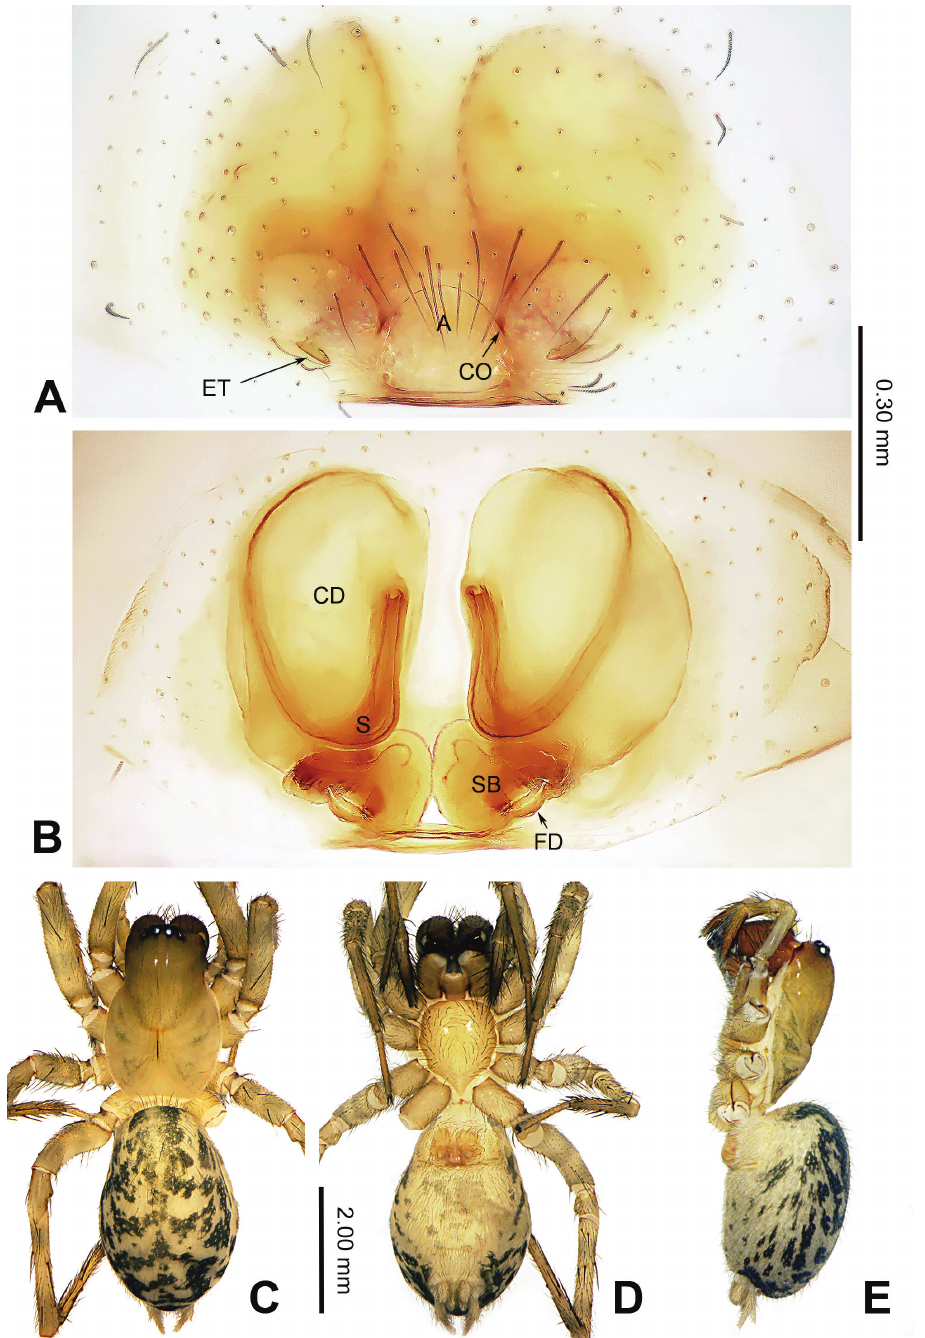
Figure 7. Epigyne and habitus of Guilotes yandongensis sp. n. A Epigyne, ventral B Vulva, dorsal C Female habitus, dorsal D Female habitus, ventral E Female habitus, lateral. Scale bars equal for C–E